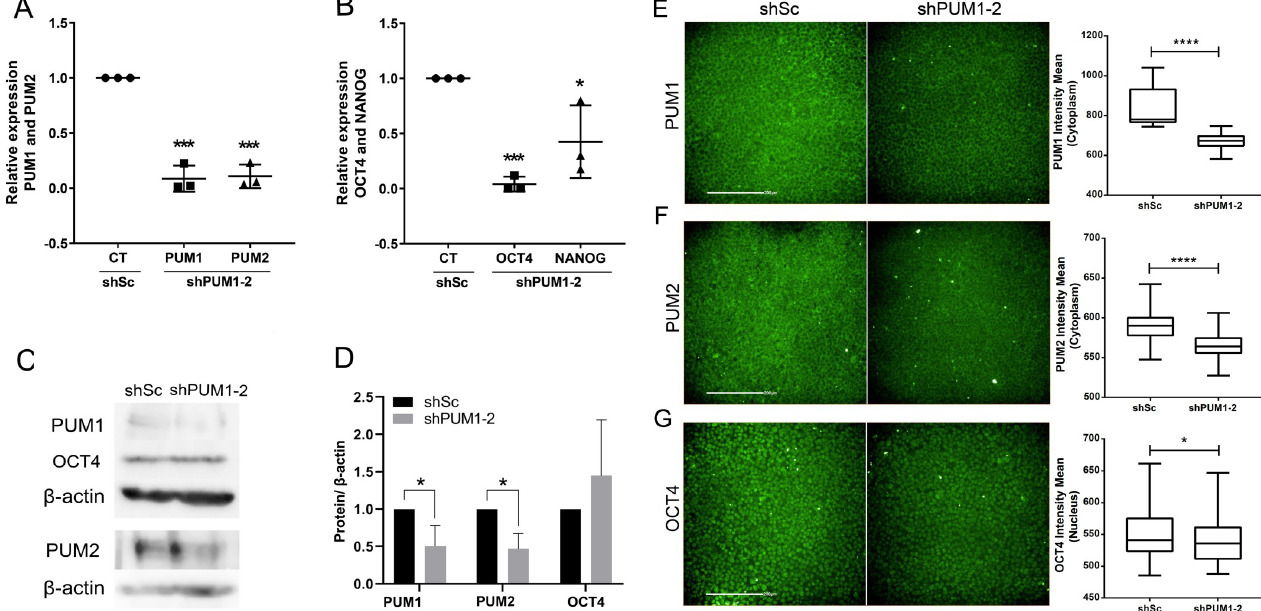
Fig 1. Knockdown of PUM1 and PUM2 affects the expression of OCT4 and NANOG mRNA. (A-B) Analysis of the relative expression of PUM1 and PUM2 (A) and of NANOG and OCT4 (B) in hESCs 24 h after transduction of lentiviral vectors containing shSc and sh PUM1-2 (n = 3). (C-D) Western blot analysis of PUM1 (140 kDa), PUM2 (114 kDa) and OCT4 (40 kDa) expression in protein extracts from cells in which PUM1-2 was silenced. The β -actin (45 kDa) protein was used as a loading control (n = 3). (E-G) The PUM1, PUM2 and OCT4 immunostaining intensity of each individual cell (n = 74,000 cells) was analyzed using Operetta CLS and Harmony 4.5 software (Perkin Elmer); for each sample, 25 images (20X objective) in triplicate were analyzed. Representative immunostaining images and quantified intensity of PUM1 (E), PUM2 (F) and OCT4 (G) 48 h after transduction of lentiviral vectors containing shSc and shPUM1-2 are shown. Scale bars: 200 μ m. � p < 0.05, �� p < 0.01, ��� p < 0.001, ���� p < 0.0001.